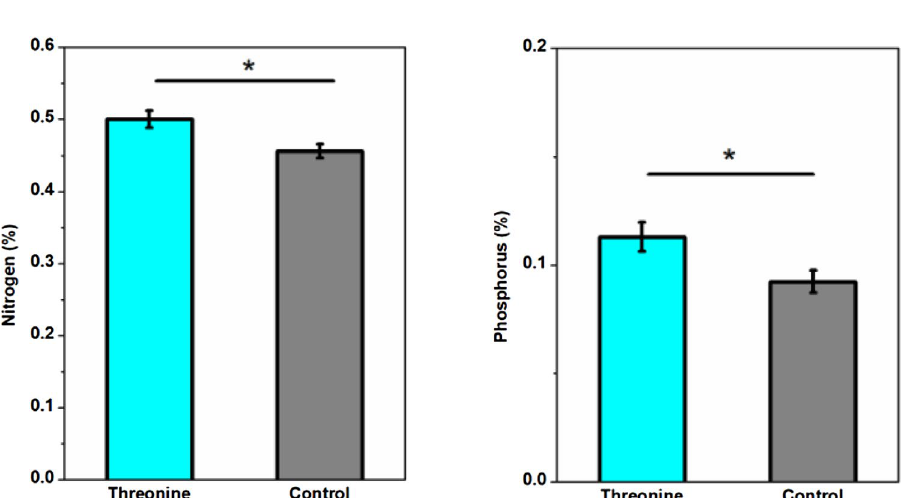
Figure 4. Nitrogen and phosphorus concentrations (%) in corn plant dry roots between exogenous applied threonine and an untreated control. Elemental concentrations were compared by